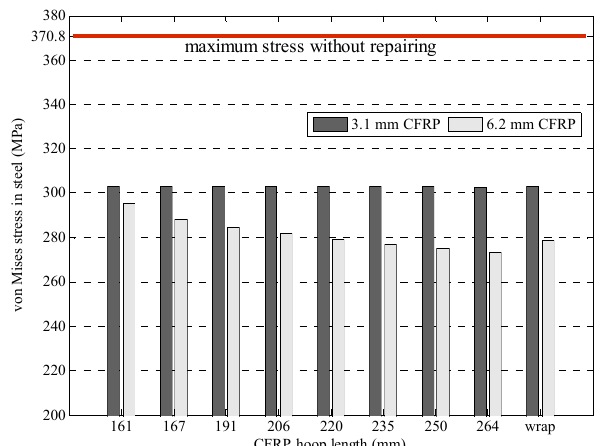
Figure 4. Maximum von Mises stress in the pipe wall for different CFRP sizes.